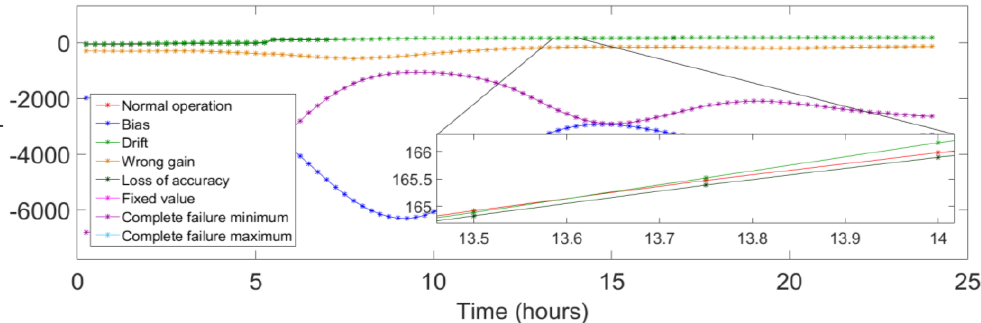
Figure 4. Drift diagnosis: graphs of the FDA discriminant functions gi(x) for each of the normal and seven fault classes, along the 24 h of the 140th day and the detailed representation revealing the class of the observations and the time moment of the firm fault type identification.